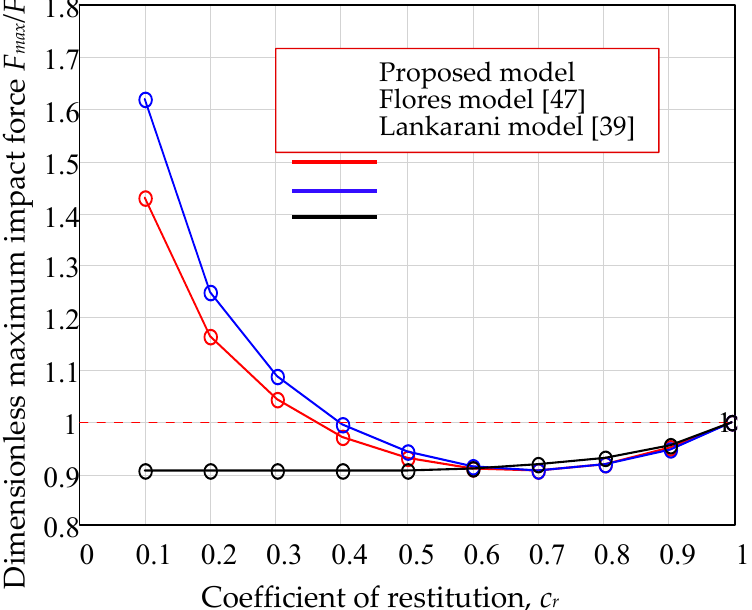
Figure 25. The variation of maximum impact force ( F max ) versus the coefficient of restitution ( c r